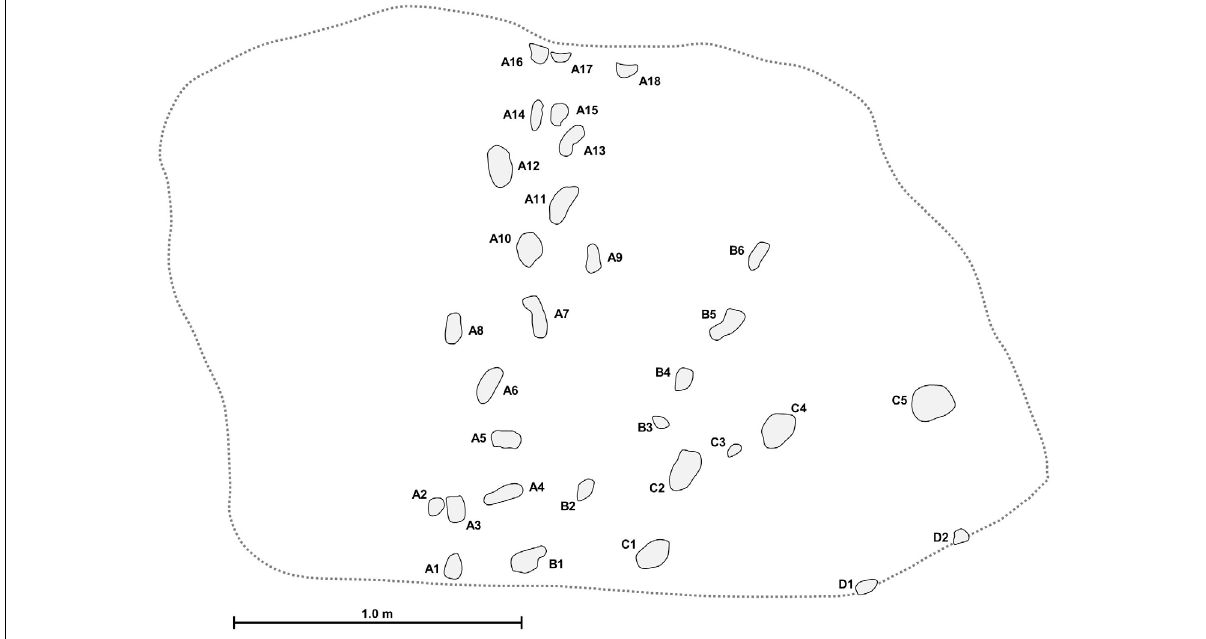
Figure 7: Trackway map of Site